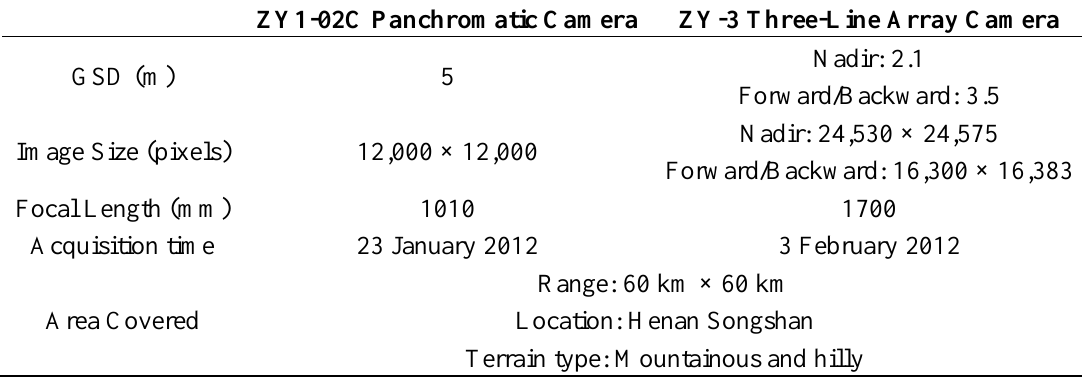
Table 1. Specific information about the satellite imagery data.